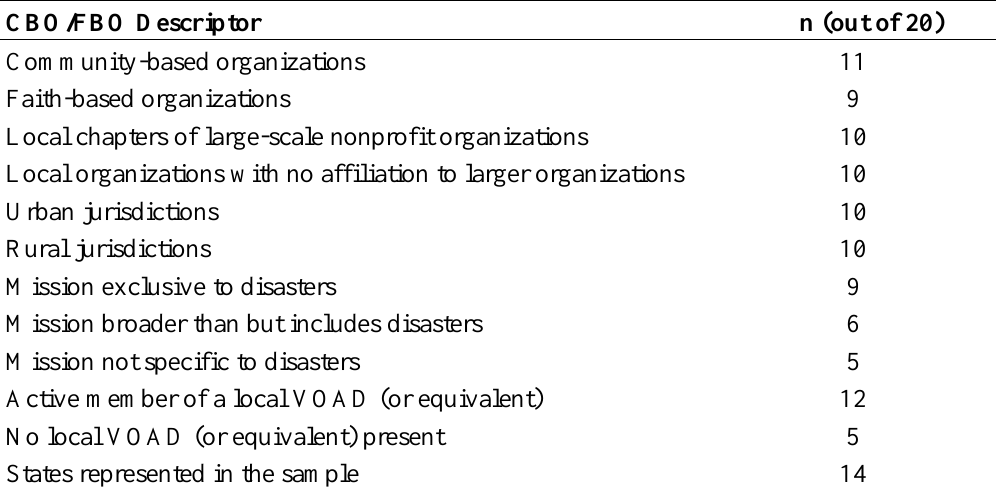
Table 1. Characteristics of sampled